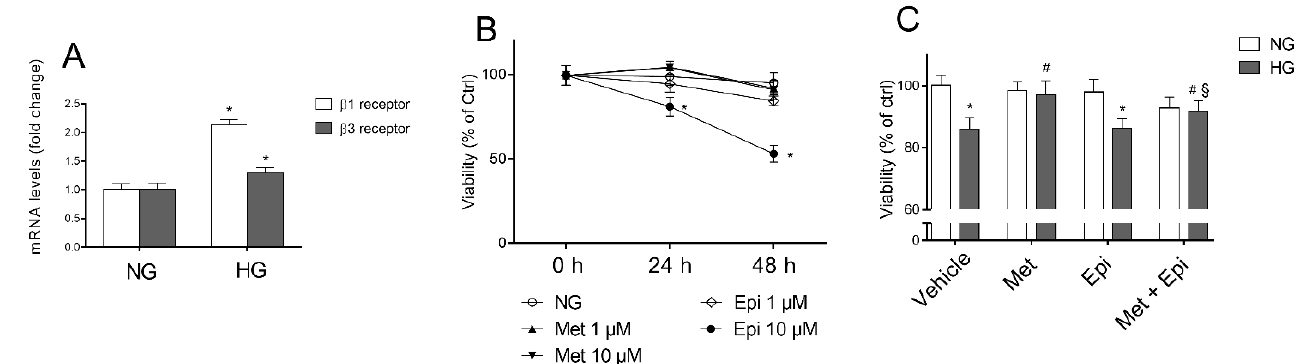
Figure 1. The effects of metoprolol and epinephrine on HREC that were treated with HG. ( A ) β1- and β3-adrenergic receptor mRNA levels, evaluated by qRT-PCR after 48 h of treatment with normal glucose levels (NG, 5 mM) or with high glucose levels (HG, 25 mM). ( B ) Cell viability that was evaluated by MTT assay in cells that were treated for 24 and 48 h with NG in the presence of 1 and 10 μM of metoprolol (Met), 1 and 10 μM of epinephrine (Epi). ( C ) The cell viability that was evaluated by MTT assay in cells that were treated for 48 h with NG or HG (vehicle), in cells that were treated for 48 h with NG or HG in the presence of 10 μM of metoprolol (Met), or 1 μM of epinephrine (Epi), or in the presence of both compounds (Met + Epi). The values are expressed as the mean ± SD of three independent experiments with four parallel samples for group in each experiment. * p < 0.05 vs. NG; # p <0.05 vs. HG; § p < 0.05 vs. HG-Epi. The non-parametric Mann-Whitney test was used for pairwise comparisons.